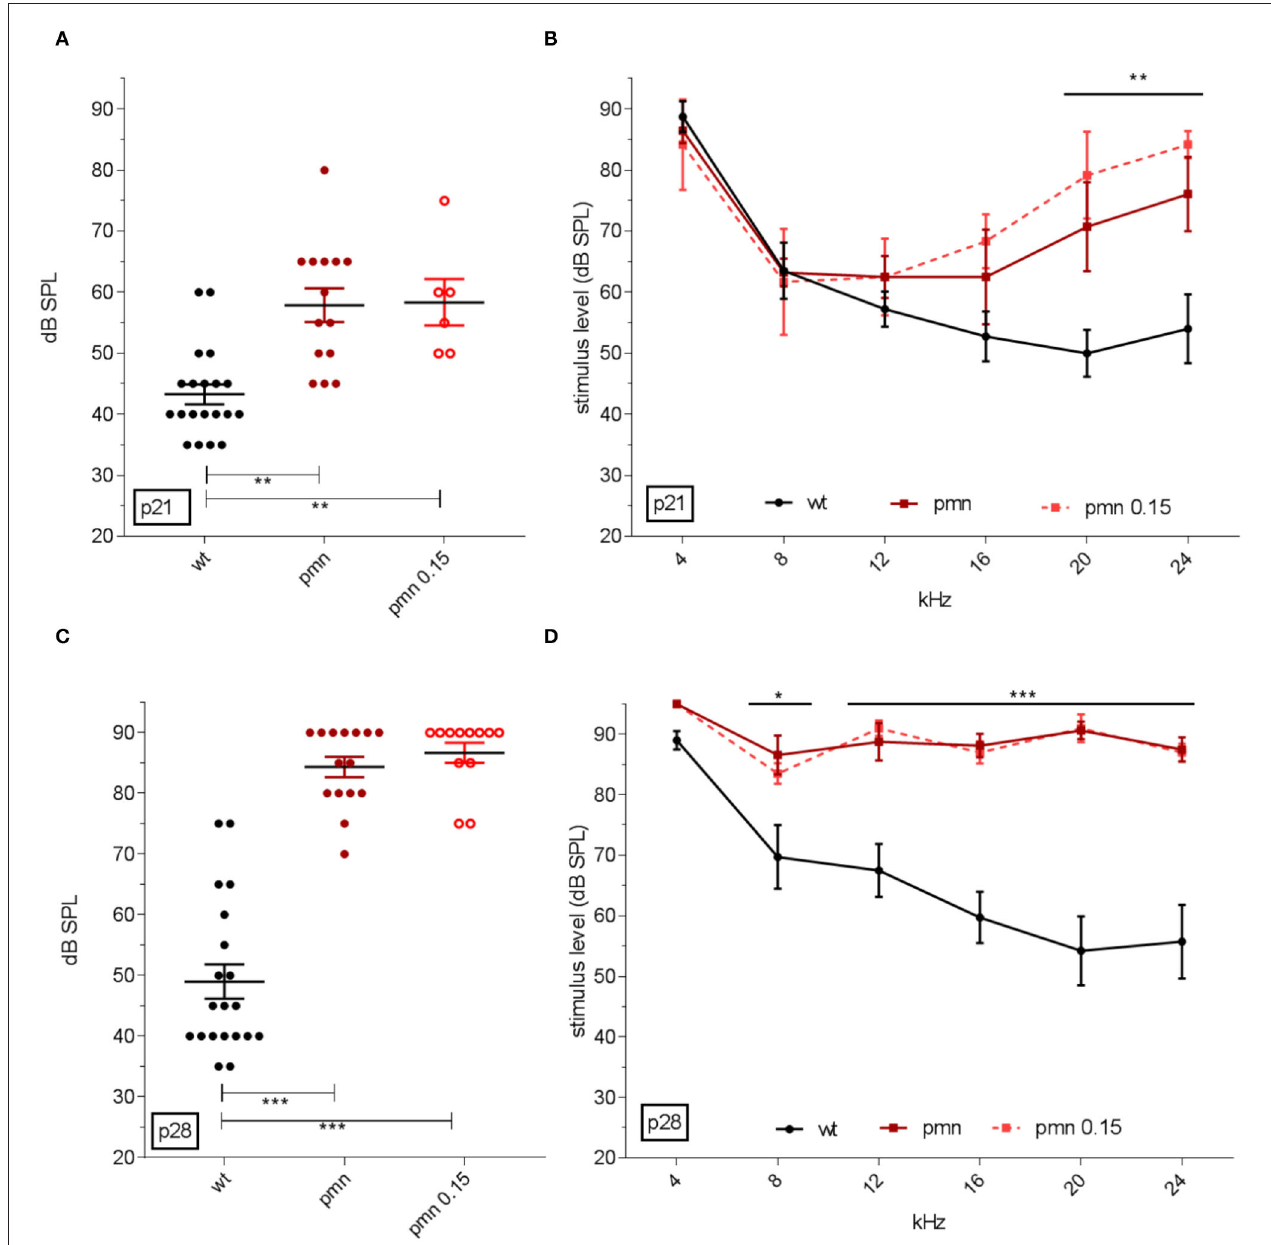
FIGURE 4 | ABR click and tone hearing threshold. (A) Hearing threshold of click ABR and (B) frequency-specific thresholds at p21 in dB SPL. Click ABR showed an increased threshold in PMN mice ( p < 0.01) and tone-specific ABR indicated an increased threshold at the higher frequencies of 20 and 24kHz ( p < 0.01). Peg-IGF-1 had no benefit on the click and tone-specific ABR. Similar results could be seen in (C) the threshold of click ABR and (D) frequency-specific thresholds at p28. Click ABR analysis showed an increased threshold of both PMN groups ( p < 0.001) and an increasing threshold at the frequencies 8 ( p < 0.05), as well as 12, 16, 20, and 24kHz ( p < 0.001). Click ABR threshold: Ordinary one-way ANOVA with multiple comparison test and Hold-Sidak post hoc analysis. Tone ABR: Regular two-way ANOVA with multiple comparison tests and Tukey post hoc analysis. Significances: * p < 0.05, ** p < 0.01, *** p < 0.001.